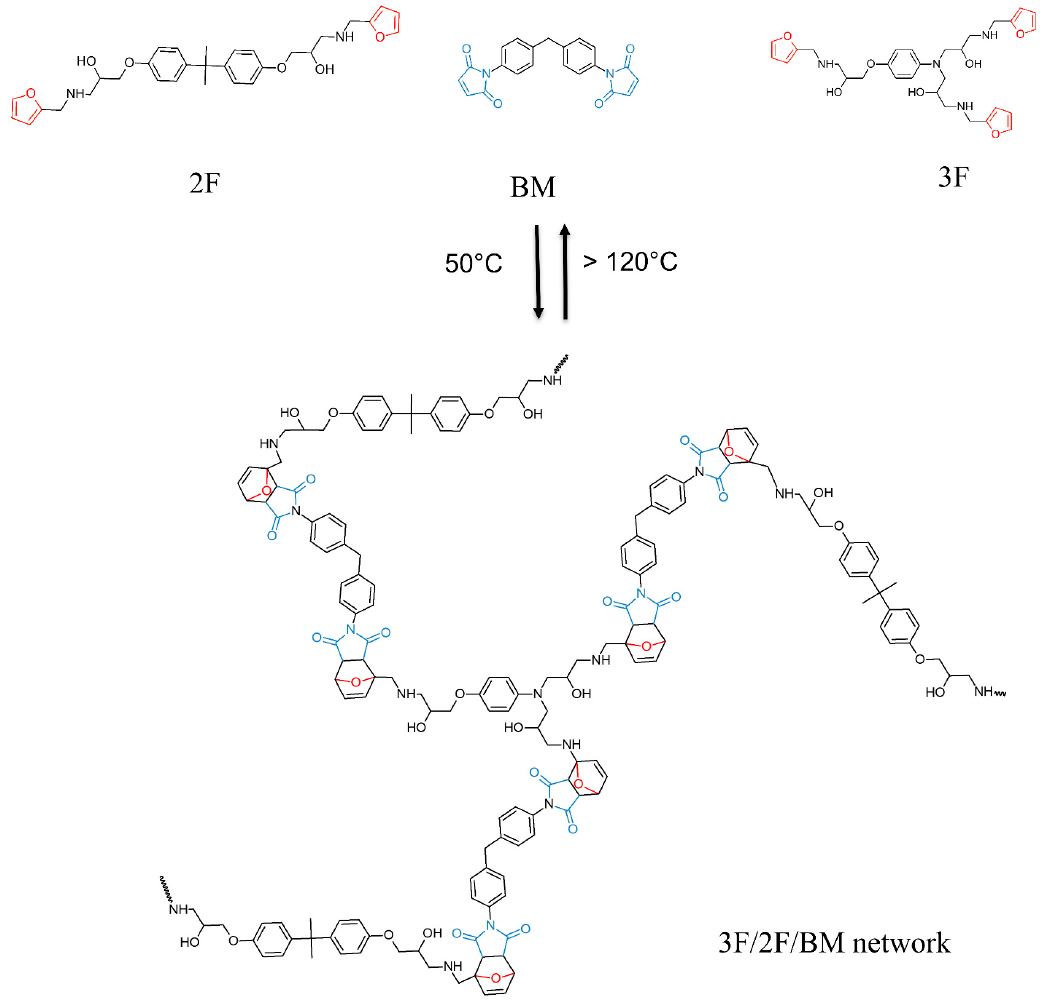
Scheme 1. Schematic representation of cross-linking and de-cross-linking of